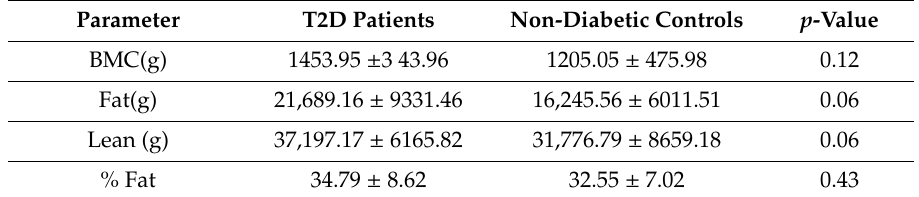
Table 7. Comparison of whole-body composition on DEXA (body-head).